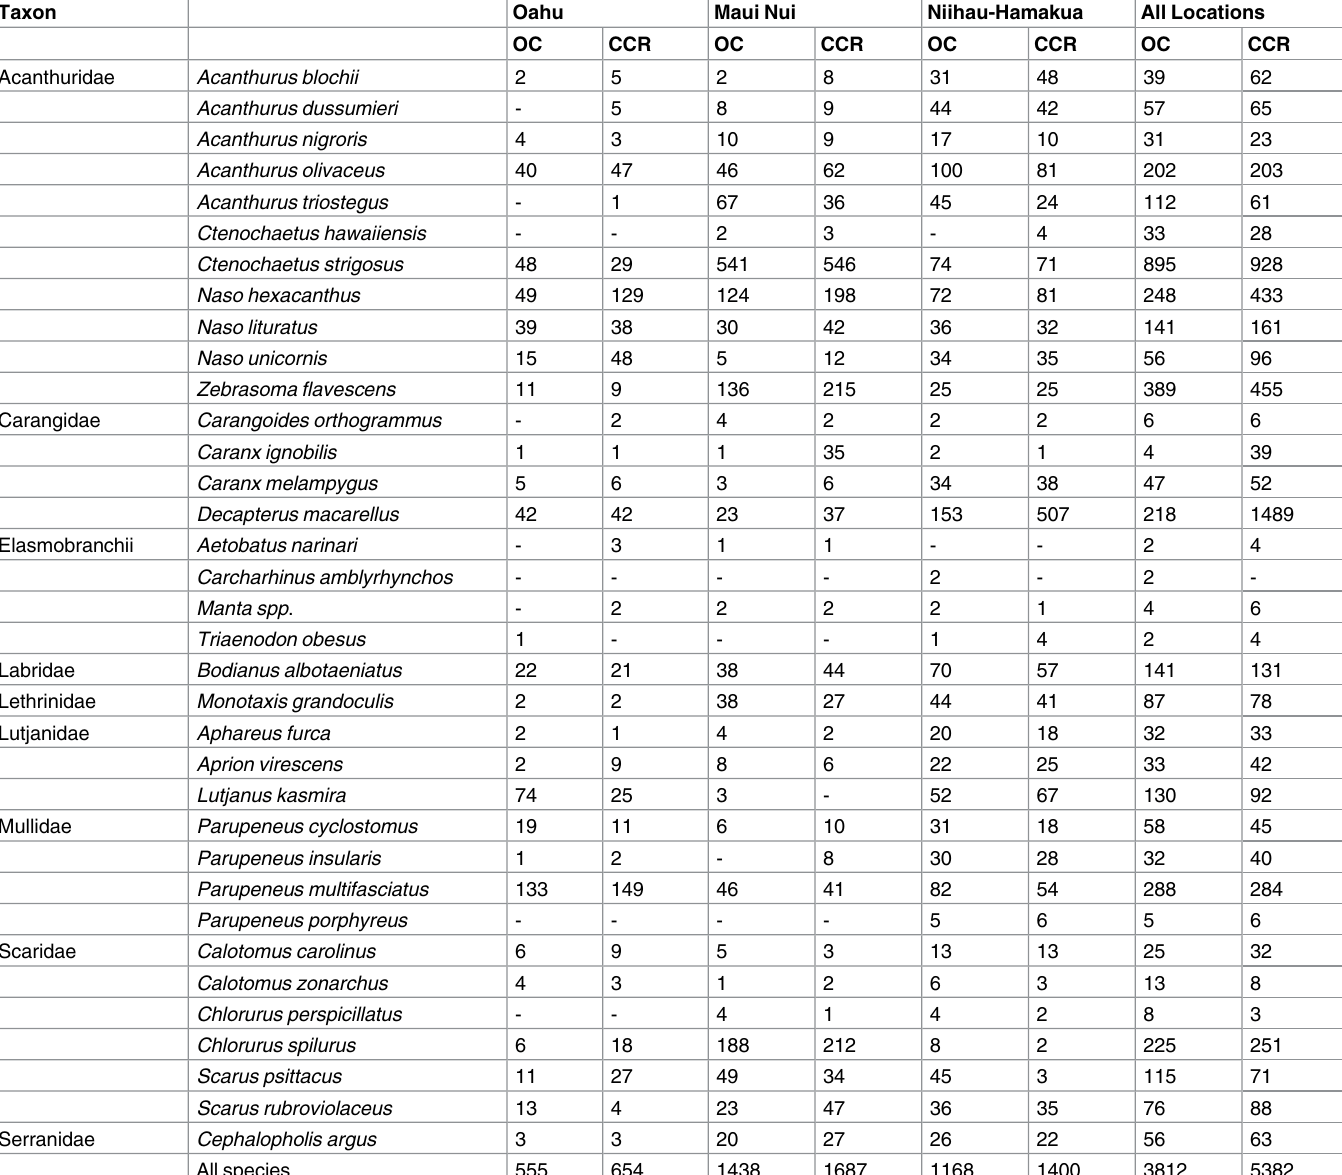
Table 1. Total counts for all observed high interest and high target species at each location group and all locations. All locationsincludesOahu (n = 15), Maui Nui (n = 20), Niihau-Hamakua (n = 22) West Hawaii(n = 6) and South Kauai (n = 3).